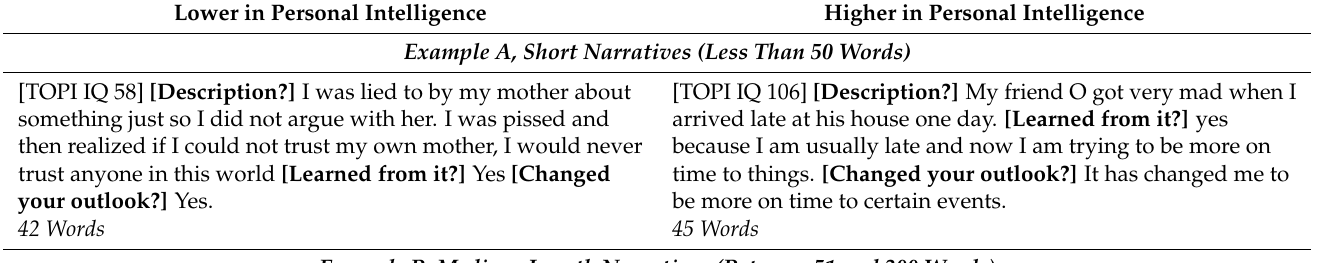
Table 6. Deidentified Examples of Narratives of Three Different Lengths from People High and Low in Personal Intelligence in Response to the Narrative Survey Questions